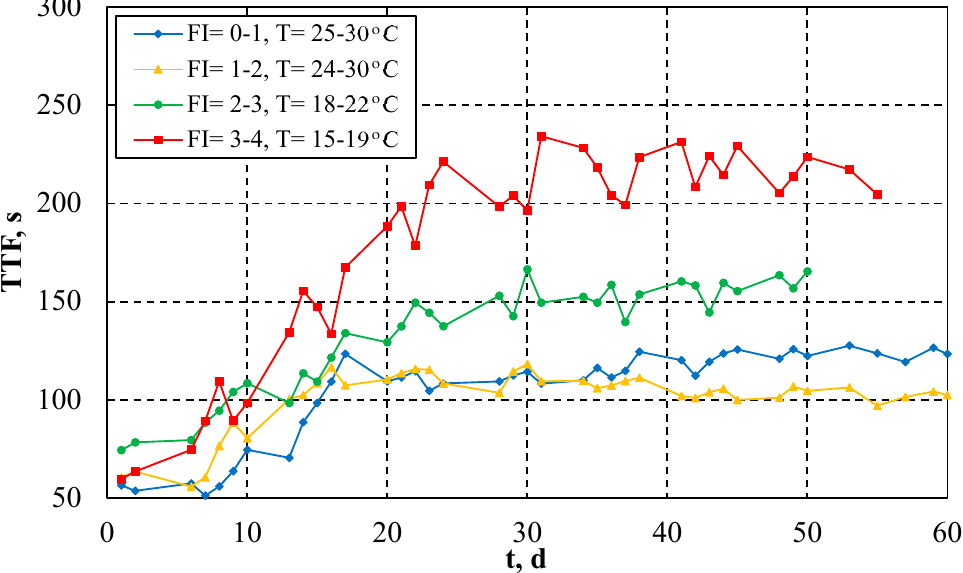
Figure 6. Effect of FI and temperature on sludge filterability (TTF).